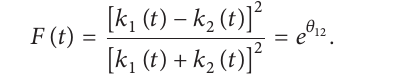
Substitution of (19) into (22)